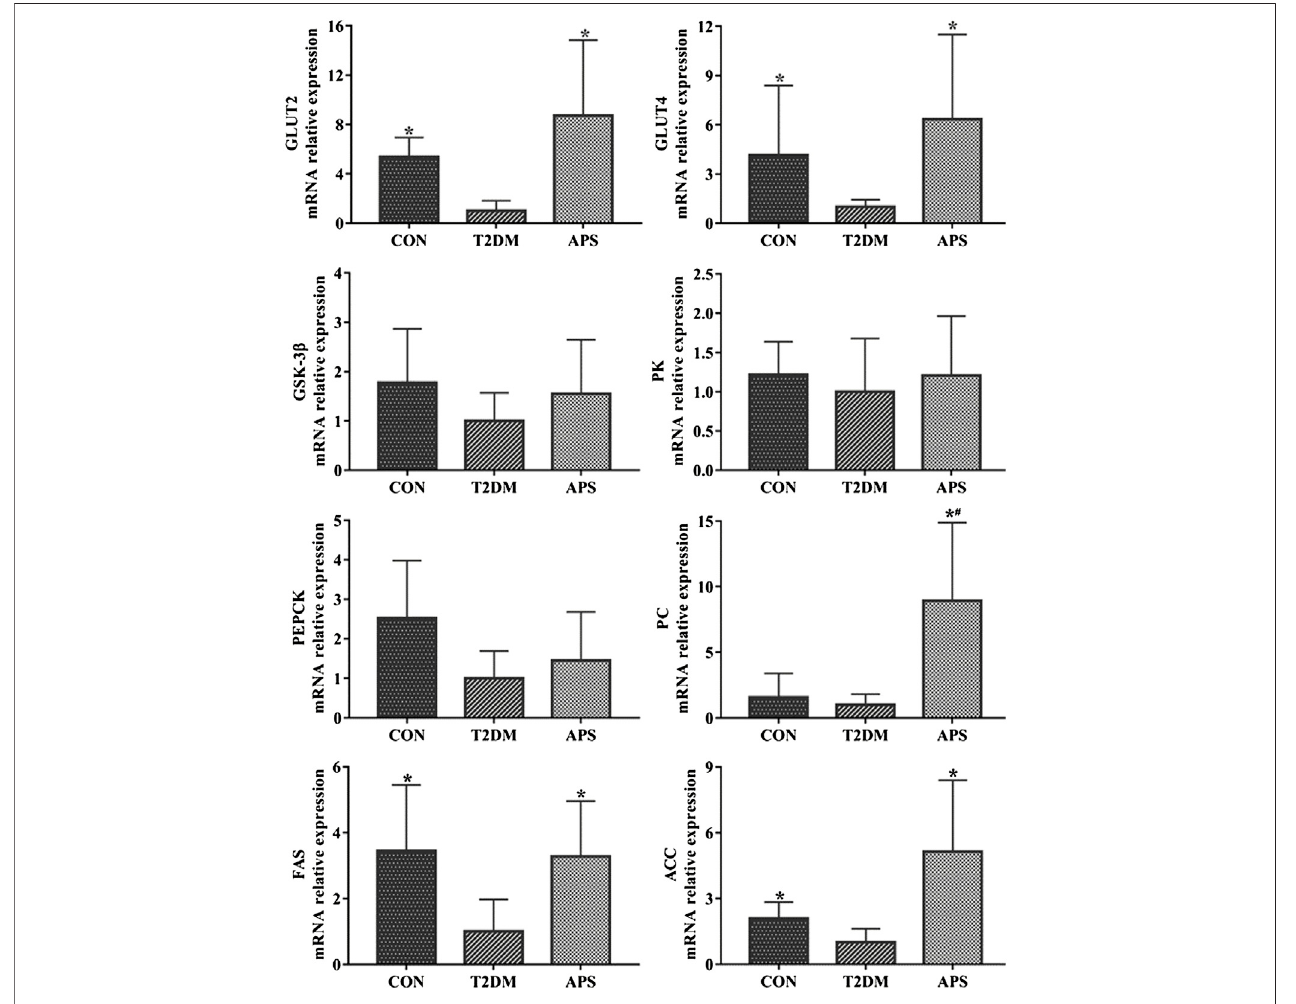
FIGURE 3 | mRNA expressions of genes related to glucose and lipid metabolism in liver of experimental rats. * p < 0.05, compared with rats in T2DM group; # p < 0.05, compared with rats in CON group.